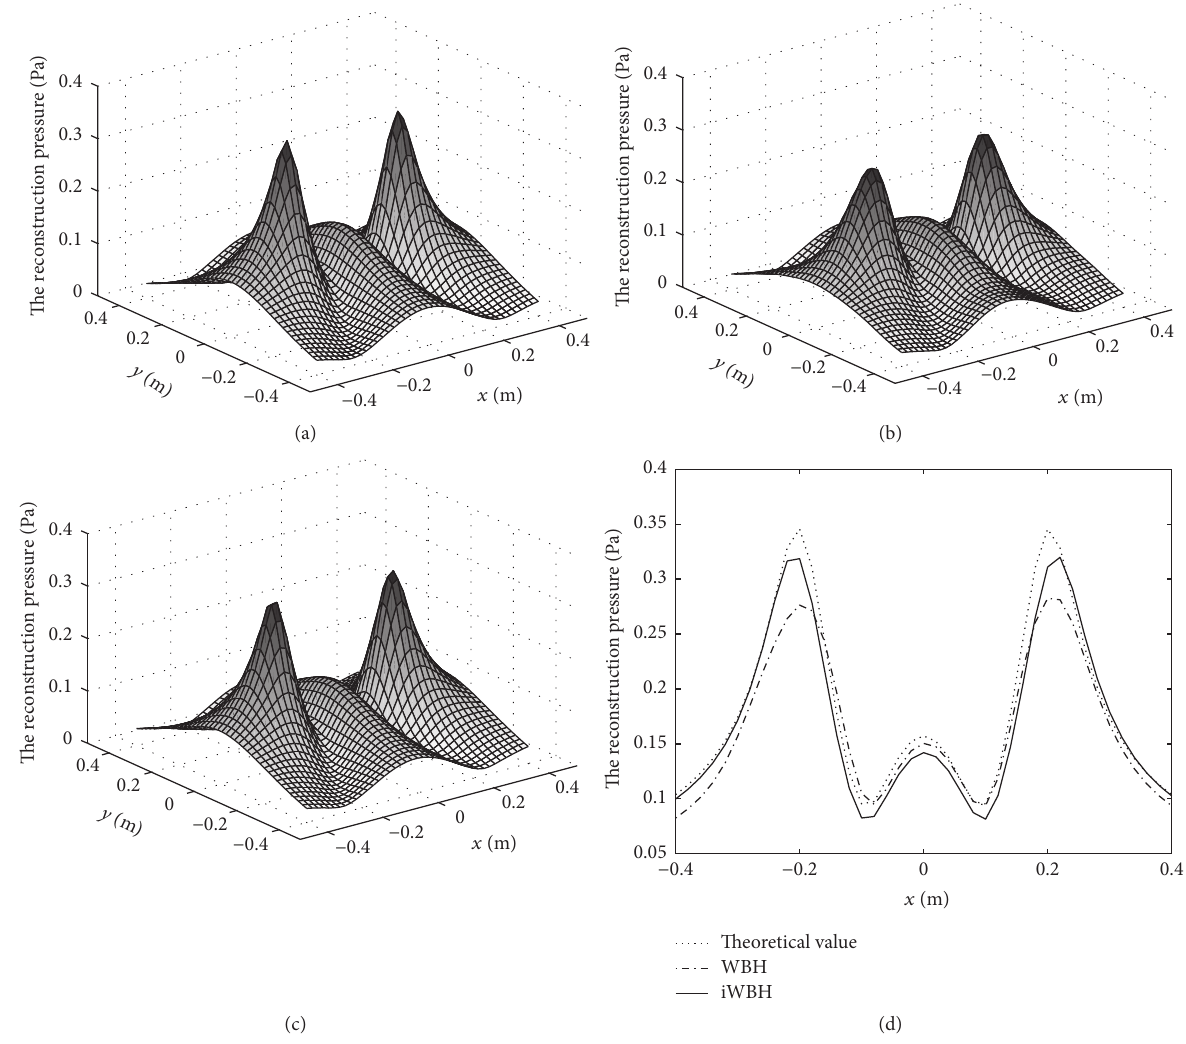
Figure 4: Comparison of reconstruction sound pressures (800Hz). (a) Theoretical value. (b) WBH. (c) iWBH. (d) The pressure along the middle